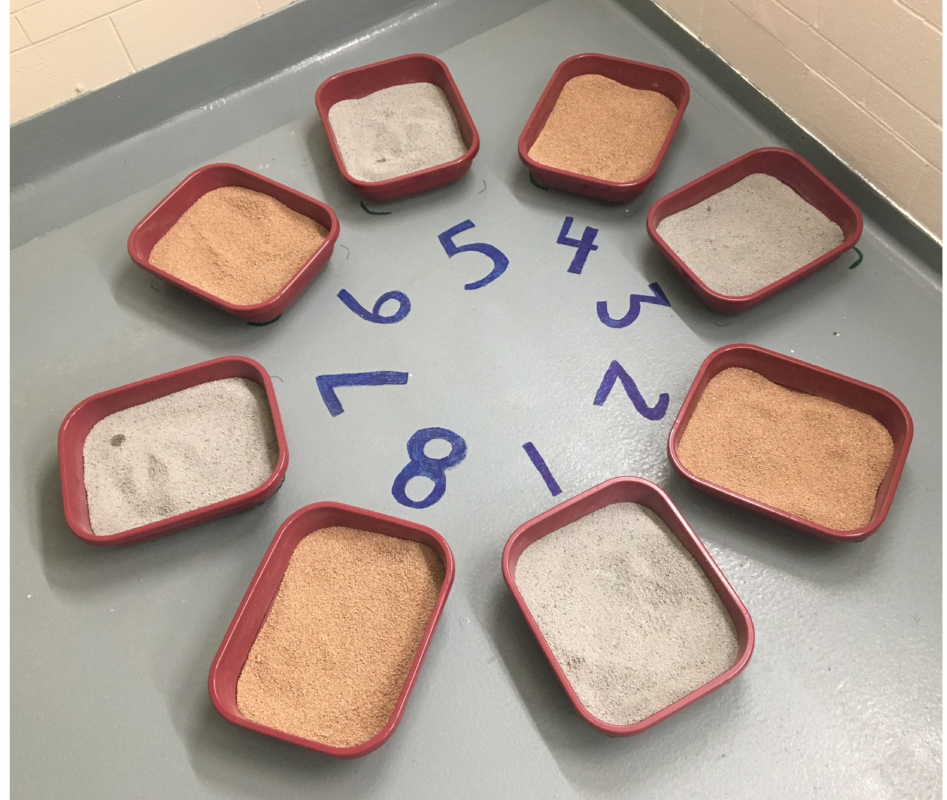
Figure 1. Arrangement of litter boxes containing alternating clay and plant-based